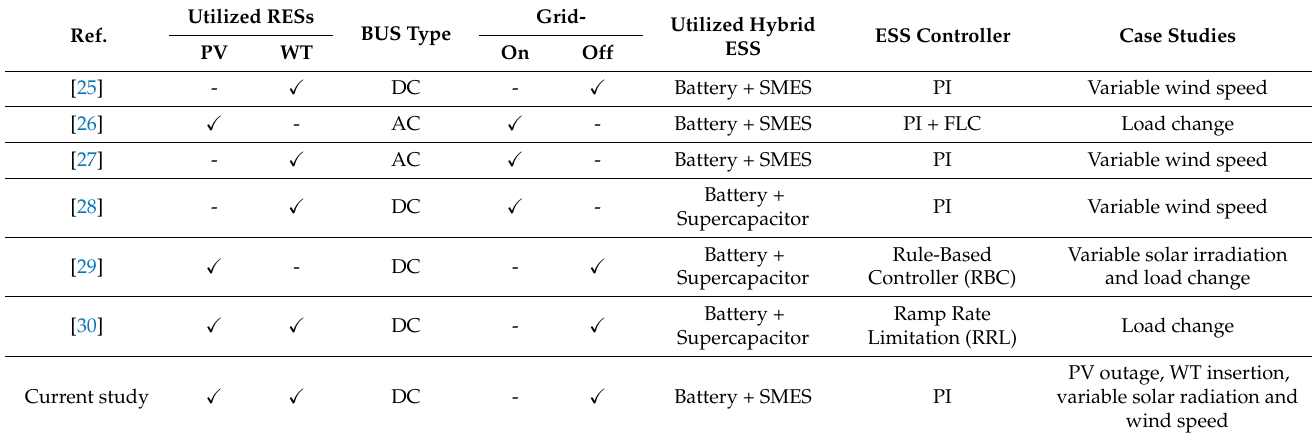
Table 1. Comparison of the most featured studies in the literature with the current study.